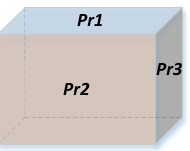
Figure 8. A simple cuboid example consisting of six planar regions.